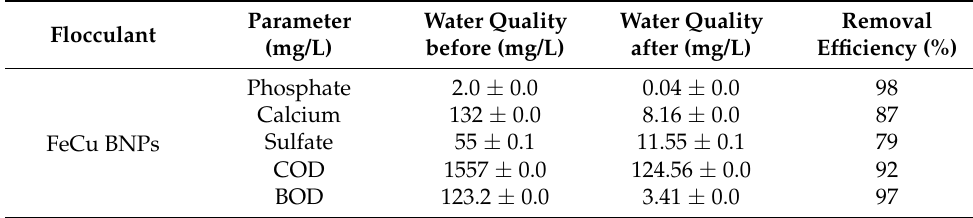
Table 2. Removal efficiency for pollutants from coal mine wastewater by FeCu BNPs at room